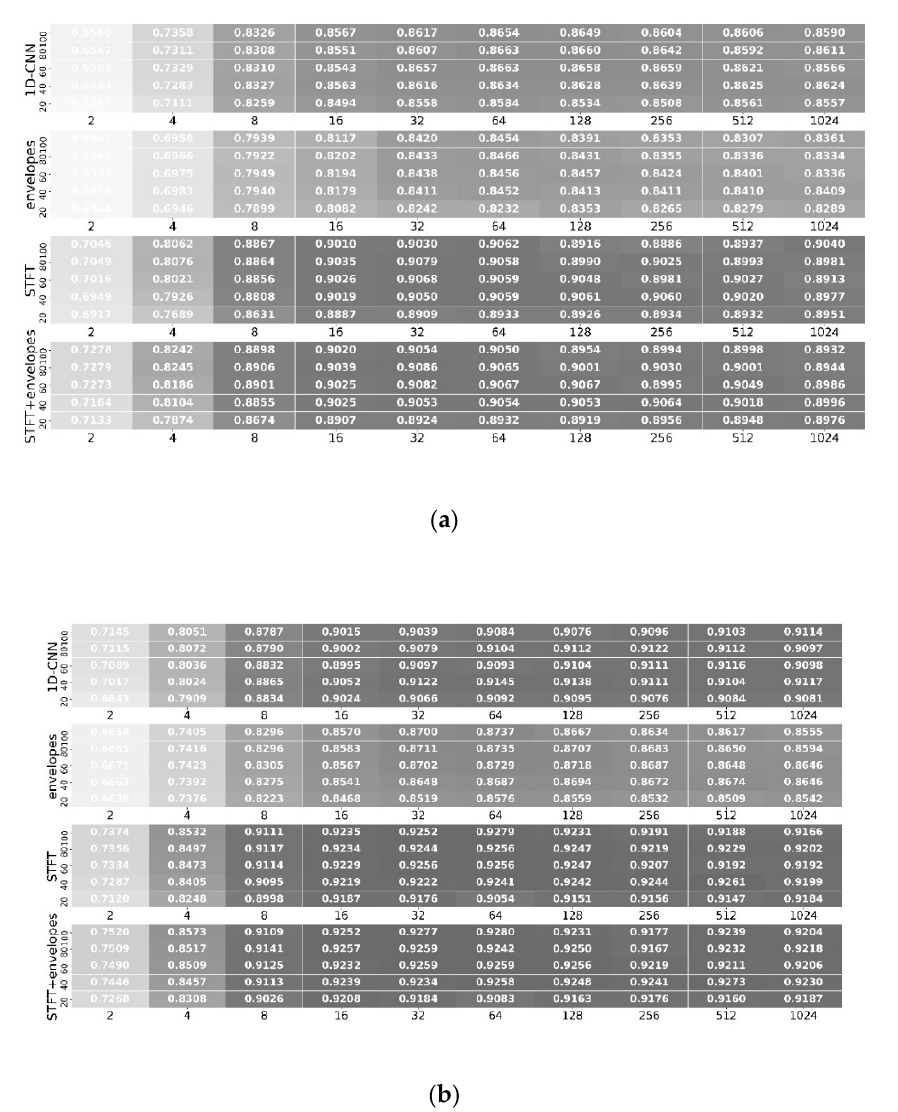
Figure 12. Visualization of the accuracy of TCN with different filter numbers and dilation structures. ( a ) PN-training-a. ( b ) LH-training. The ordinate denotes the different number of filters and abscissa represents the dilation structure. For example, abscissa number 16 indicates that the dilation structure is (1, 2, 4, 8, 16), and the meanings of other abscissa numbers are similar.